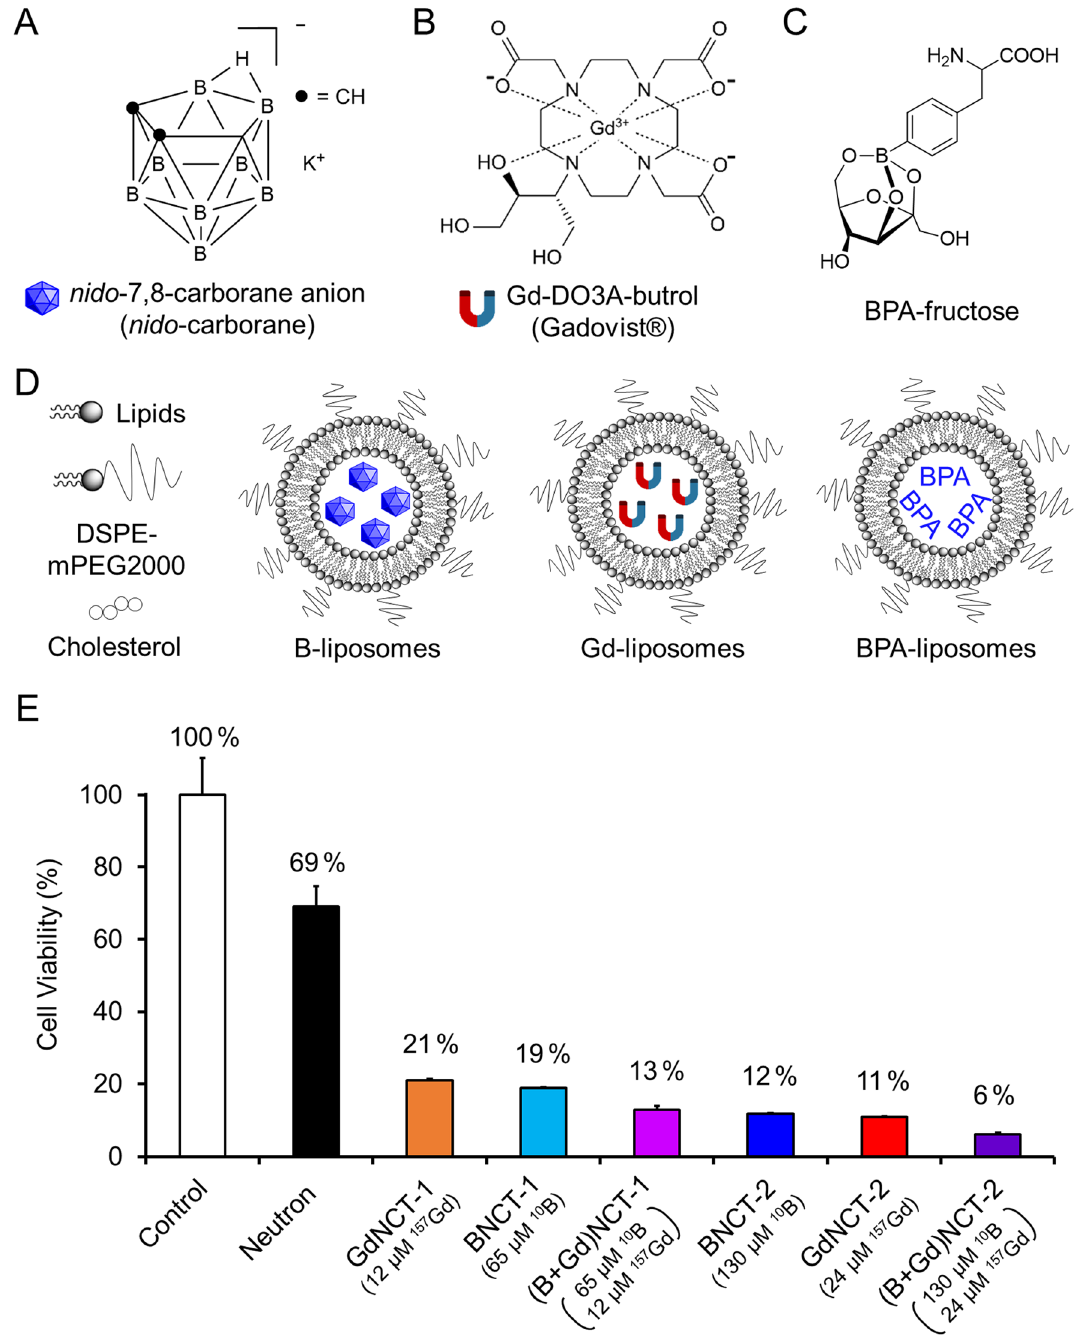
Figure 1. Schematic profiles of liposomes used in neutron capture therapy and in vitro cytotoxicity tests. Chemical structures of ( A ) nido -7,8-carborane potassium salt ( nido -carborane), ( B ) Gd-DO3A-butrol (Gadovist), and ( C ) 4-dihydroxyborylphenylalanine ‒ fructose complex (BPA ‒ fructose). ( D ) Schematic illustration of nido -carborane-encapsulated liposomes (B-liposomes), Gadovist-encapsulated liposomes (Gd-liposomes), and BPA ‒ F-encapsulated liposomes (BPA-liposomes). ( E ) Cytotoxicity of B- and Gd-liposomes in CT26 cells upon neutron irradiation (n =